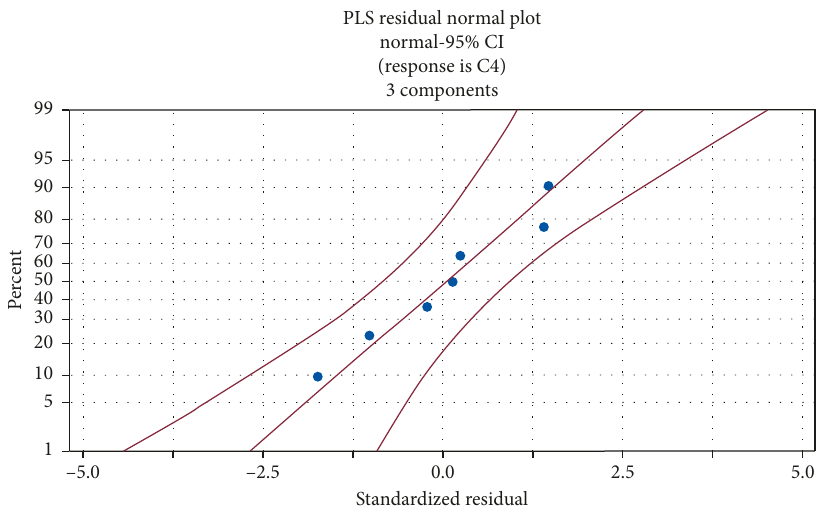
Figure 6: Model residual normal distribution